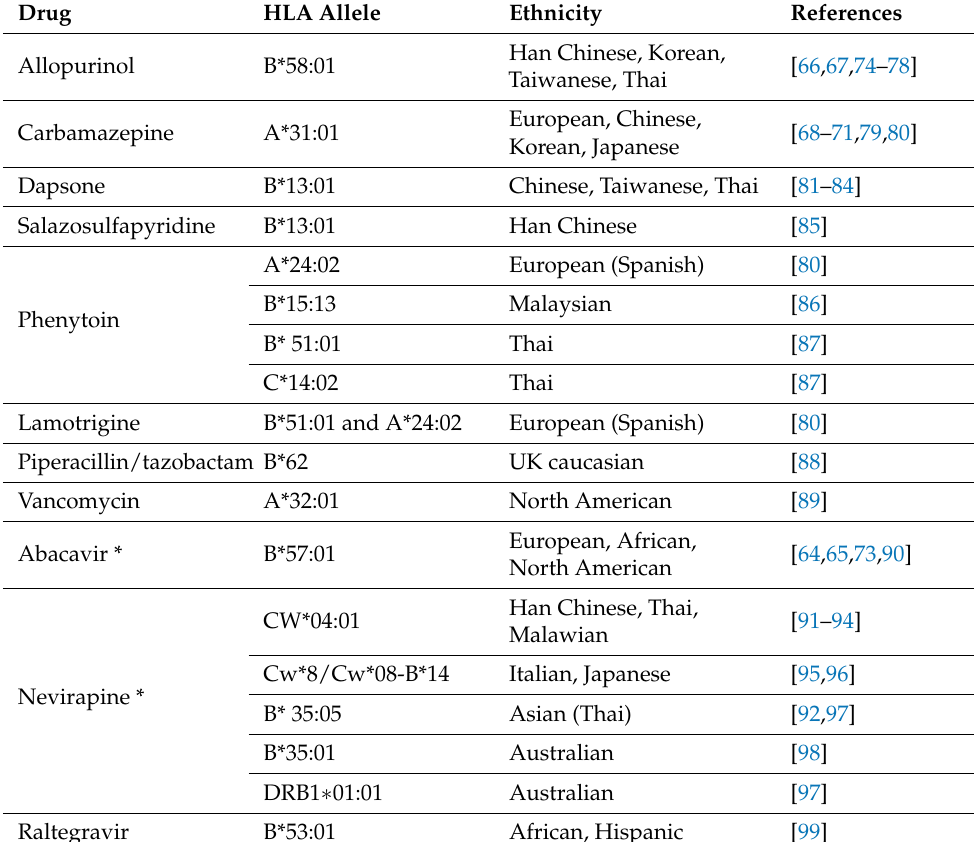
Table 2. DReSS-associated human leukocyte antigen (HLA) alleles according to drug and ethnicity. Drug HLA